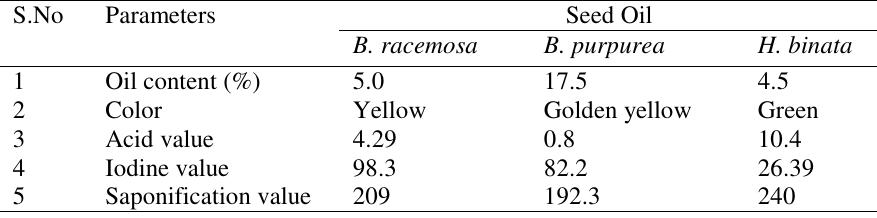
Table-3 . Data of physico-chemical analysis of seed oil